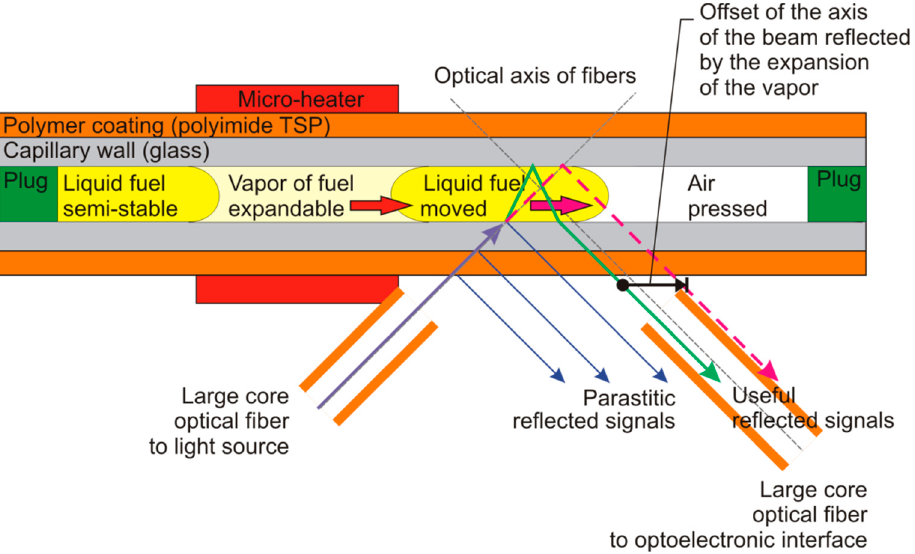
Figure 2. Diesel fuel vapor phase creation and expansion monitoring.